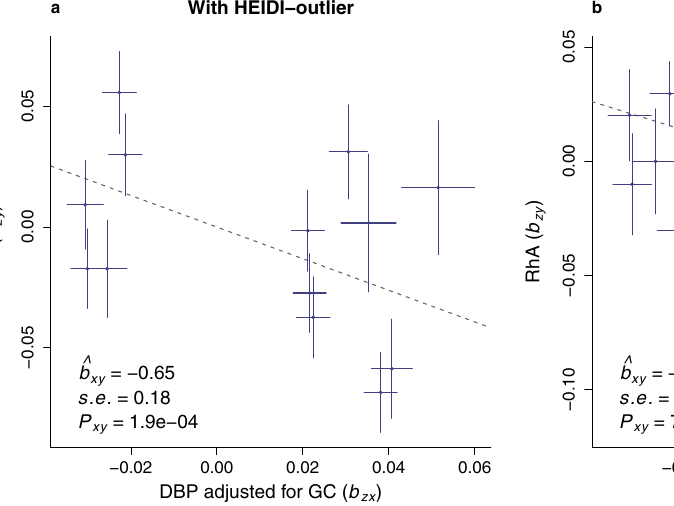
Fig. 6 | The GSMR effects of DBP concentration on multiple sclerosis (MS) and rheumatoidarthritis(RhA). TheGSMRestimatesareshownforMS(Panel a ;SNPs n =13) and RhA (Panel b ; SNPs n =12). These GSMR estimates include estimate of effect, SE, and P value, all of which were calculated by GSMR. The P value was estimatedfrom a two-tailed test. The dashed line represents the GSMR estimate of effect. Datasets used in GSMR were from GWAS summary statistics. GWAS of DBP